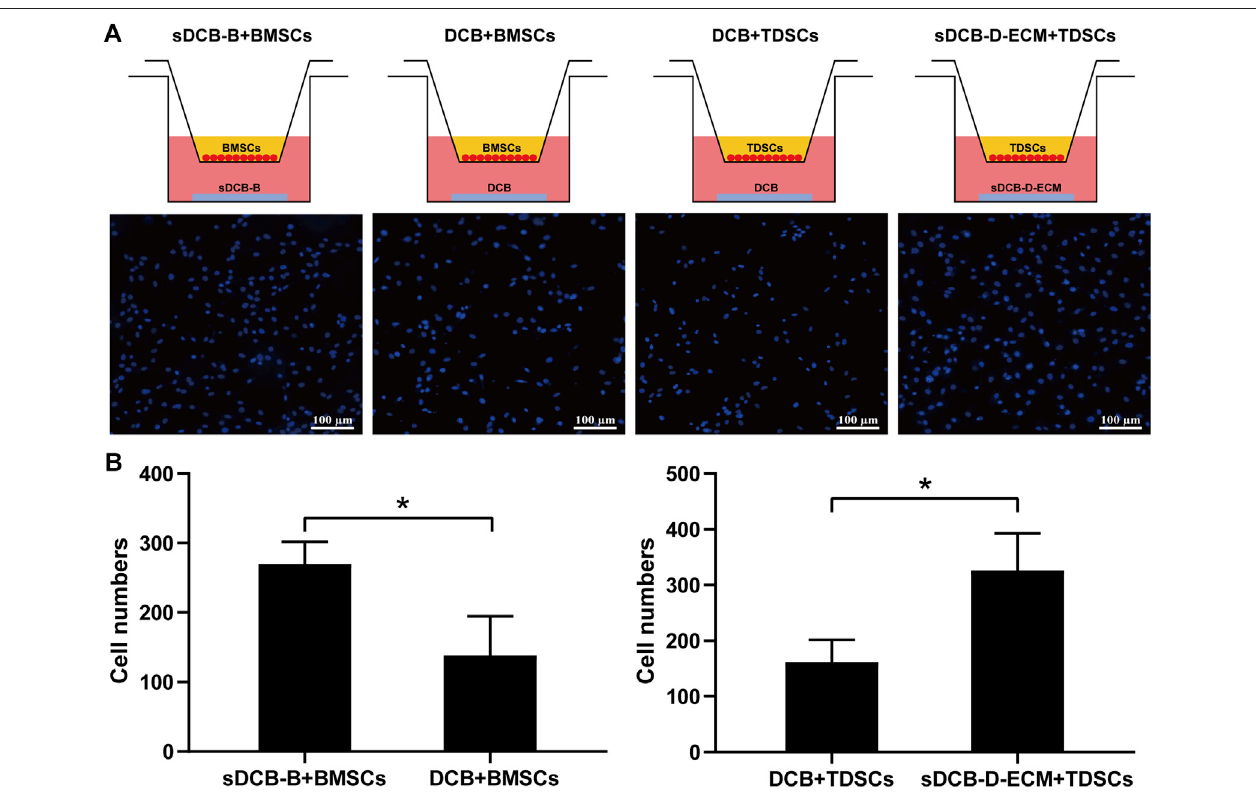
FIGURE 6 | Transwell assay analysis of the effects of sDCB-B on BMSCs migration as well as sDCB-D-ECM on TDSCs migration. (A) Fluorescence staining of migrated BMSCs and TDSCs. Scale bar (cid:1) 100 μ m. (B) Quantitative analysis of the number of migrated stem cells between groups. * Indicated p < 0.05.